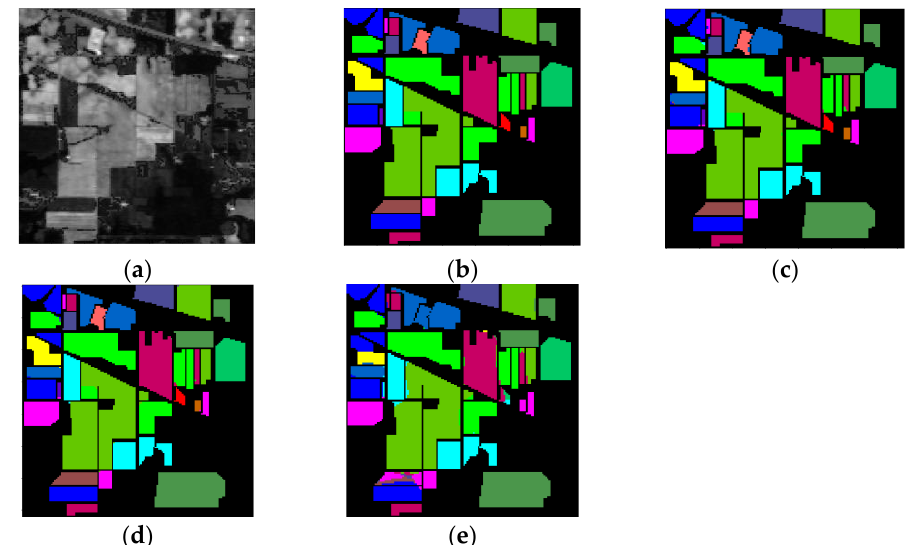
Figure 4. The confusion matrix obtained using the proposed method by using the IndianP, PaviaU, and SalinasV datasets in the first, second, and third matrices, respectively.